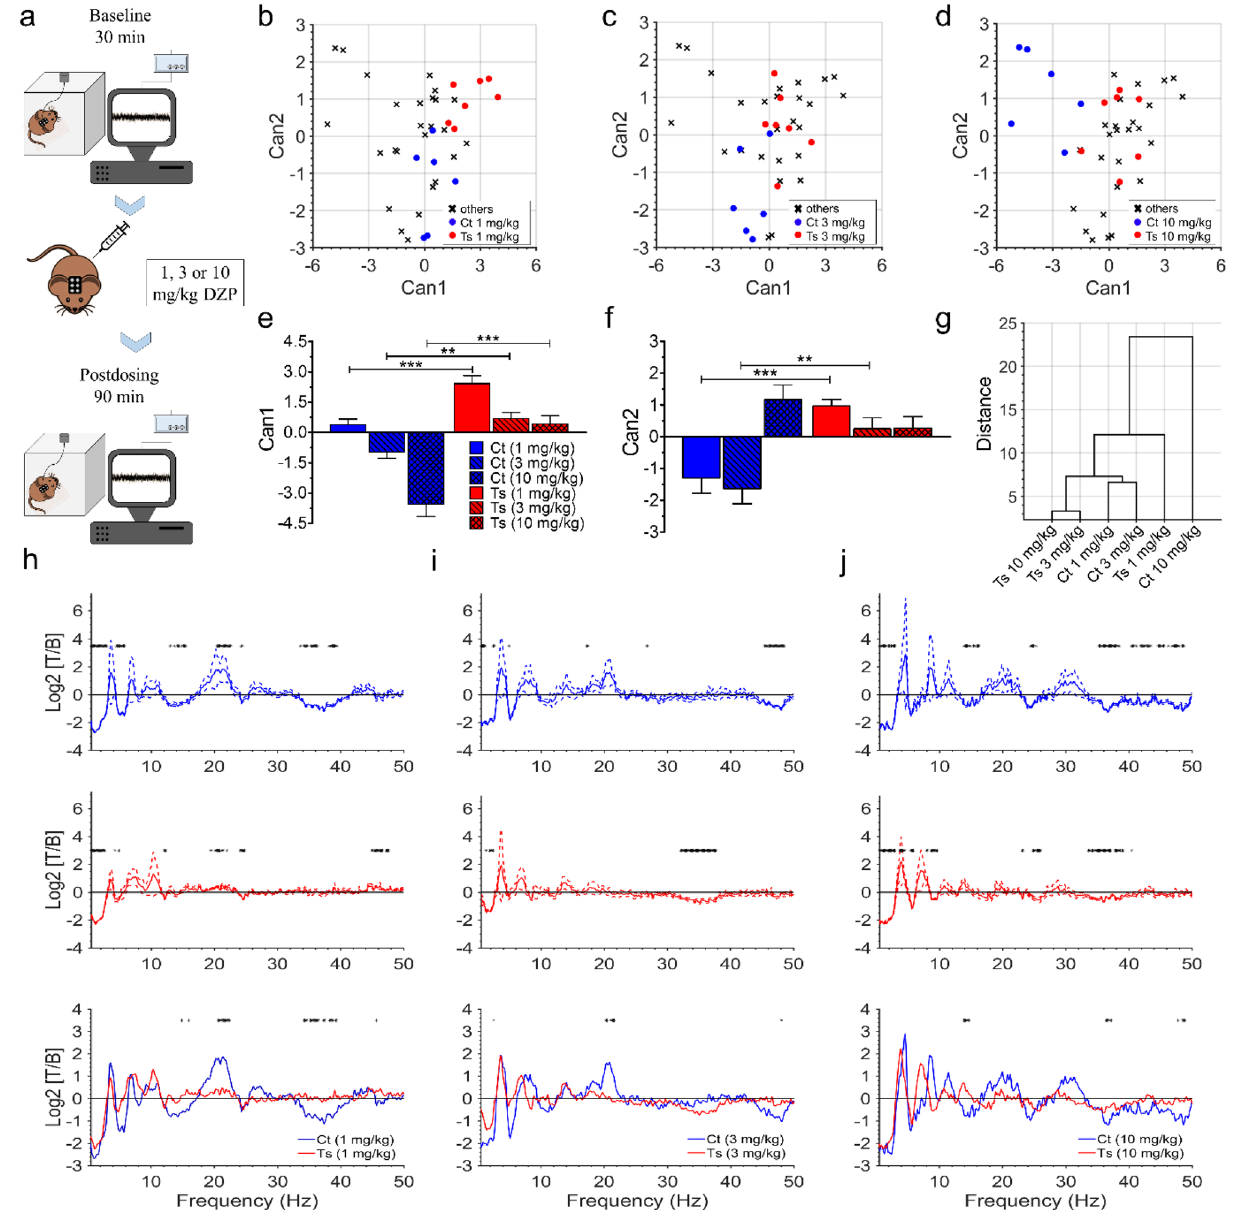
Figure 1. Diazepam induces significantly different changes on the cortical activity spectral profile of control and Ts65Dn mice. ( a ) Freely moving mice implanted with EEG electrodes were connected through a cable to the recording unit. The experiment consisted of a 30-min baseline recording, followed by a 90-min post- dosing recording, in which mice were acutely treated with 1, 3, or 10 mg/kg diazepam (i.p.). ( b – d ) Grouped scatter plots of the first two canonical variables for all mice analyzed are shown in ( b – d ) for 1-, 3-, and 10-mg/ kg doses of diazepam, respectively. Colored points represent mice and are labelled by cluster group. ( e ) Can1 discriminated the control mice group from the Ts65Dn mice group at 1-, 3-, and 10-mg/kg doses. ( f ) Can2 differentiated control and Ts65Dn mice groups at 1- and 3-mg/kg doses. ( g ) The centroid of control mice group treated with 10 mg/kg diazepam was at the highest level of the dendrogram’s hierarchical tree, whereas the centroids of Ts65Dn mice groups treated with 3- and 10-mg/kg doses had the shortest distance among all centroids. ( h – j ) PSD obtained from baseline and post-dosing recordings were compared for each dose in each genotype (black asterisks in upper and middle panels represent frequency bins in which significant differences in EEG spectral power were observed between baseline and treatment conditions; relative changes are expressed as the log 2 of the treatment/baseline ratio). Normalized PSD of control and Ts65Dn mice for each experimental condition was also compared (lower panels). Number of mice: Ct (N = 6) and Ts (N = 7) for all experimental conditions. In ( e , f ), data represent mean ± SEM and statistical significance is expressed as ** and *** for P < 0.01 and P < 0.001, respectively. In ( h – j ), solid lines represent means and dashed lines represent SEM and black asterisks indicate statistical significance ( P <